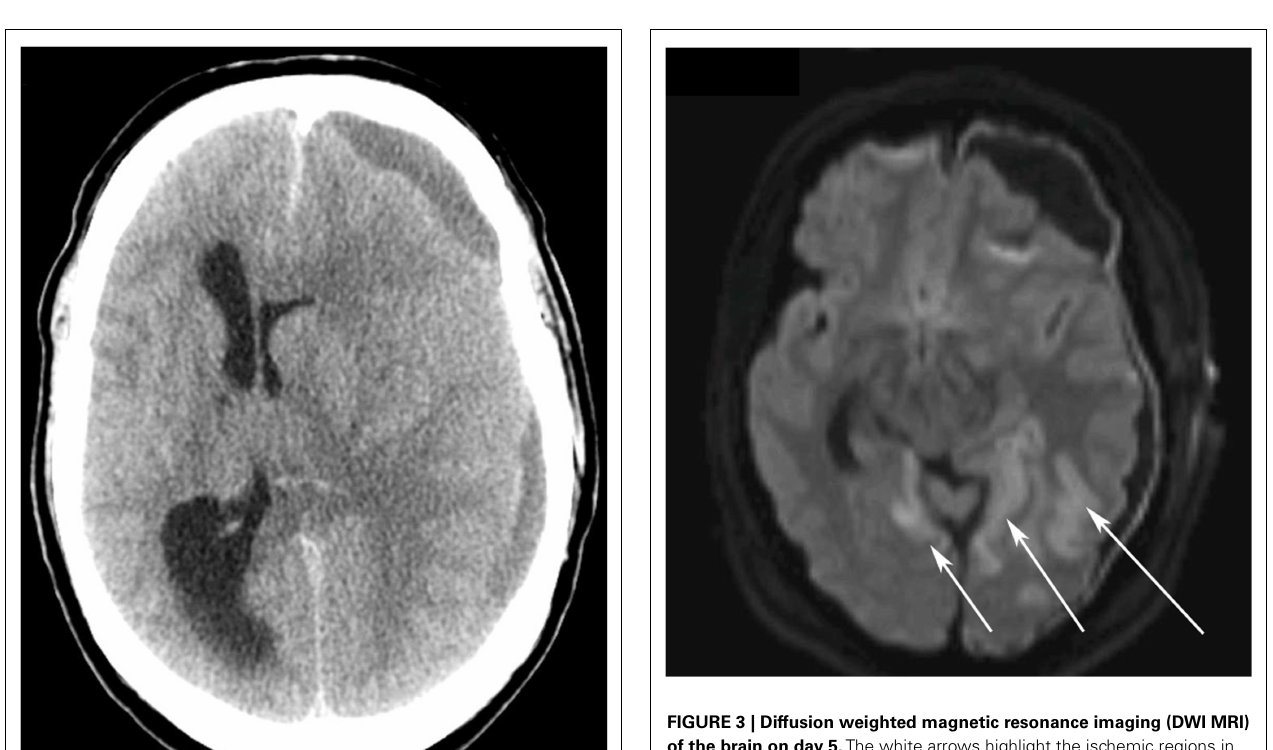
FIGURE 3 | Diffusion weighted magnetic resonance imaging (DWI MRI) of the brain on day 5. The white arrows highlight the ischemic regions in the left and right occipital